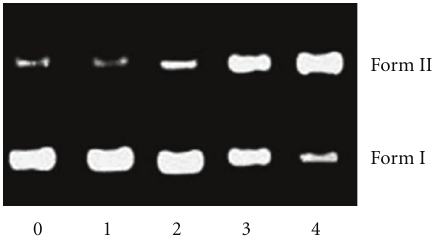
Figure 6: Photoactivated cleavage of pBR 322DNA in the presence of Re(V) complex, light after 60 minutes irradiation at λ > 400nm.